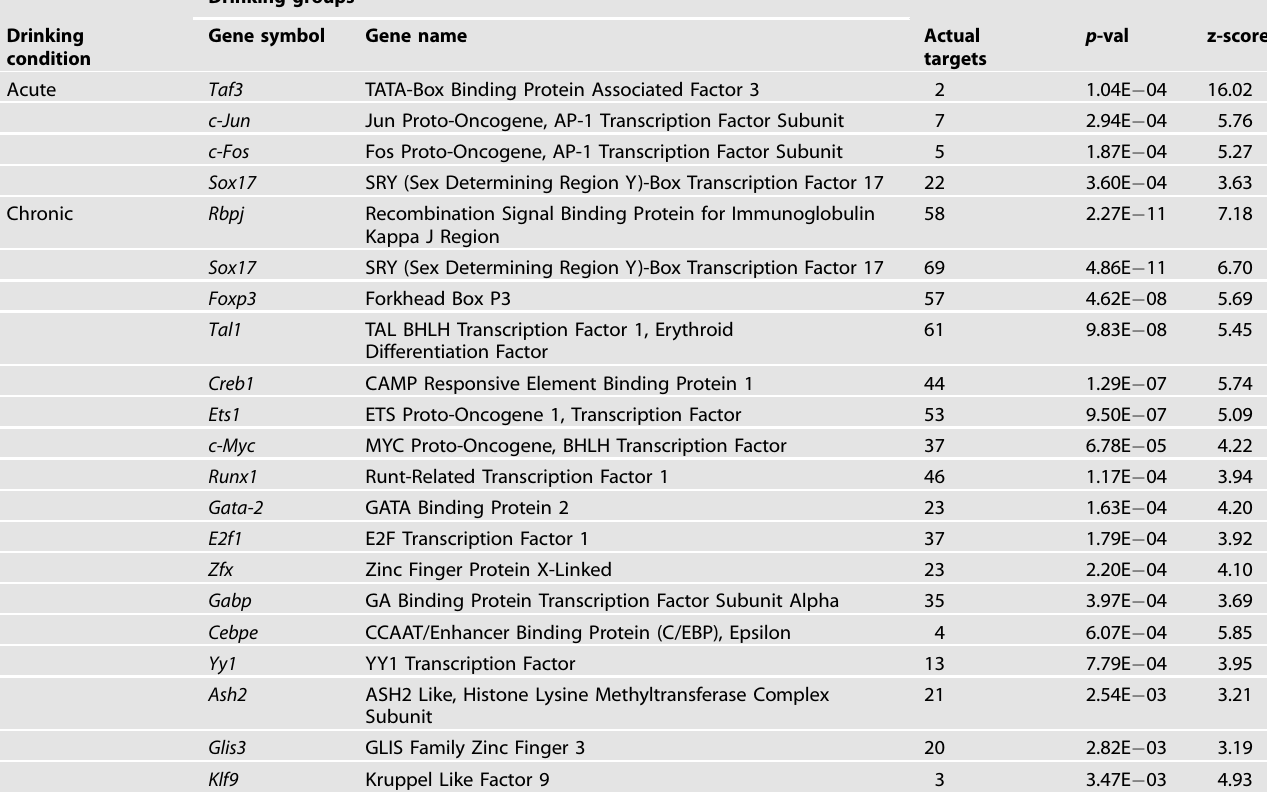
Table 2. Candidate upstream transcription factors based on DEGs associated with the Acute and Chronic Drinking